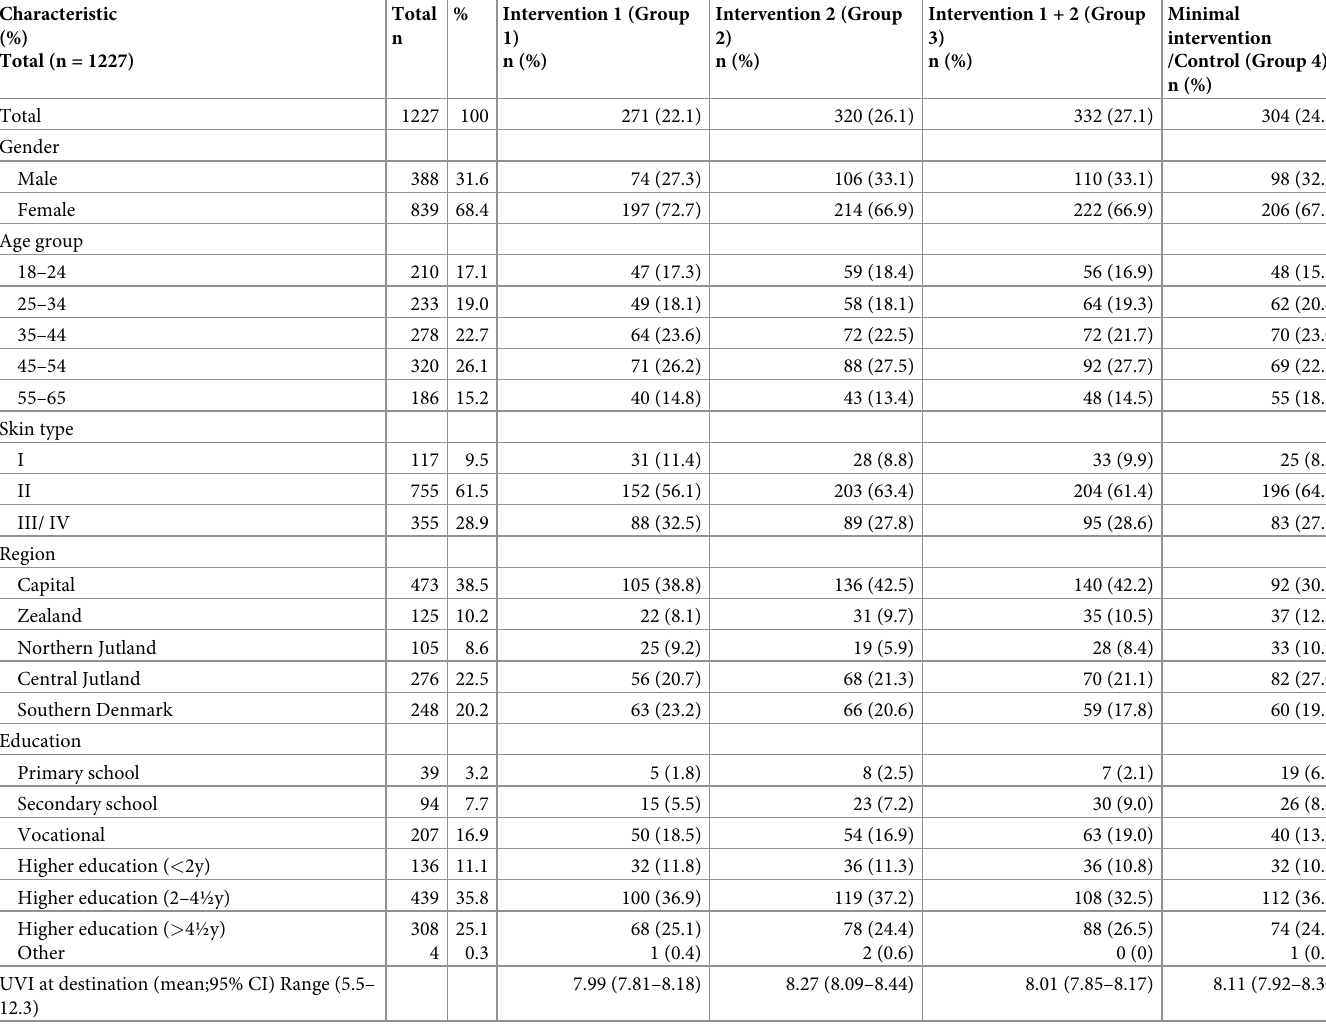
Table 1. Distribution of demographic characteristics in four armed randomized sample of 1227